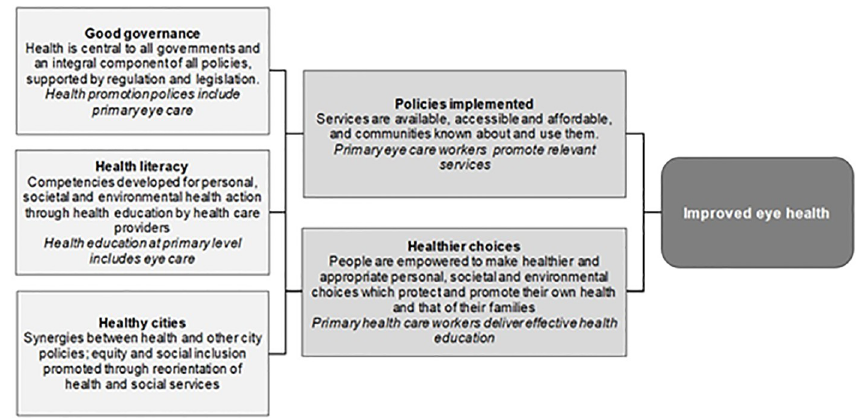
Fig 1. Conceptual model linking primary eye care to the World Health Organization’s three pillars of health promotion.